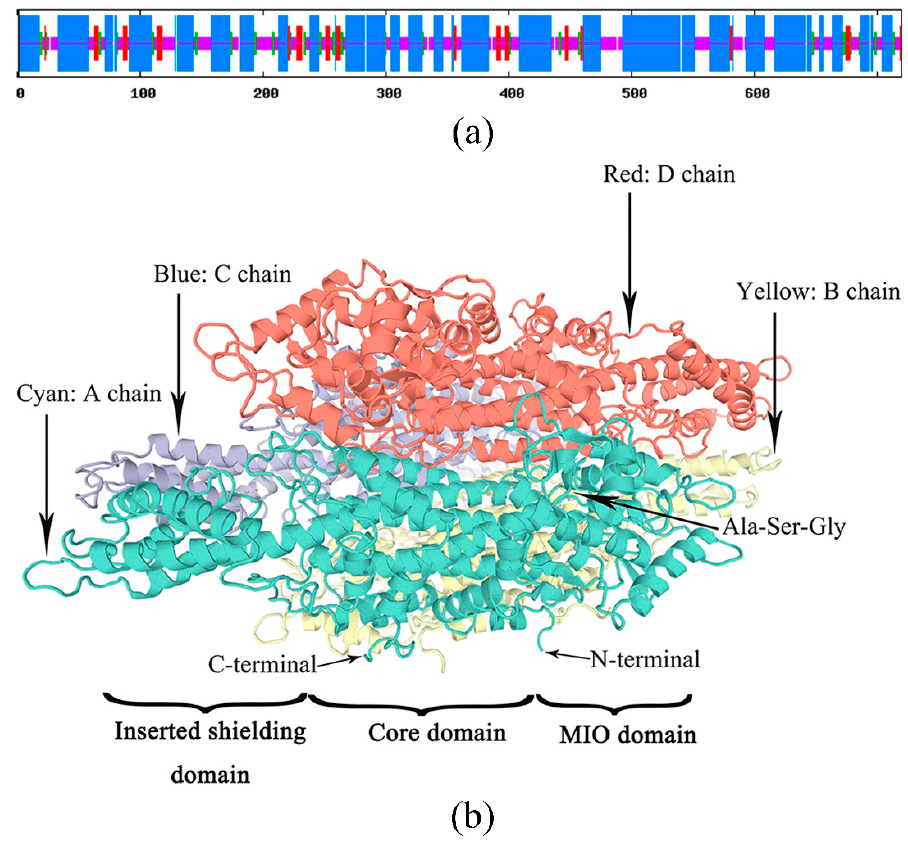
Figure 3. Prediction of PaPAL structure. ( a ) Prediction of PaPAL secondary structure; α -helix, random coil, extended strand and beta turn are represented with blue, pink, red and green regions, respectively. ( b ) Prediction of PaPAL tertiary structure.